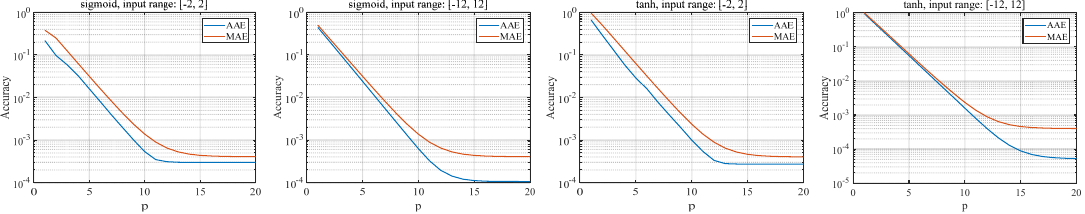
Figure 12. Accuracy simulation of computing S & T based on CSM-VLC